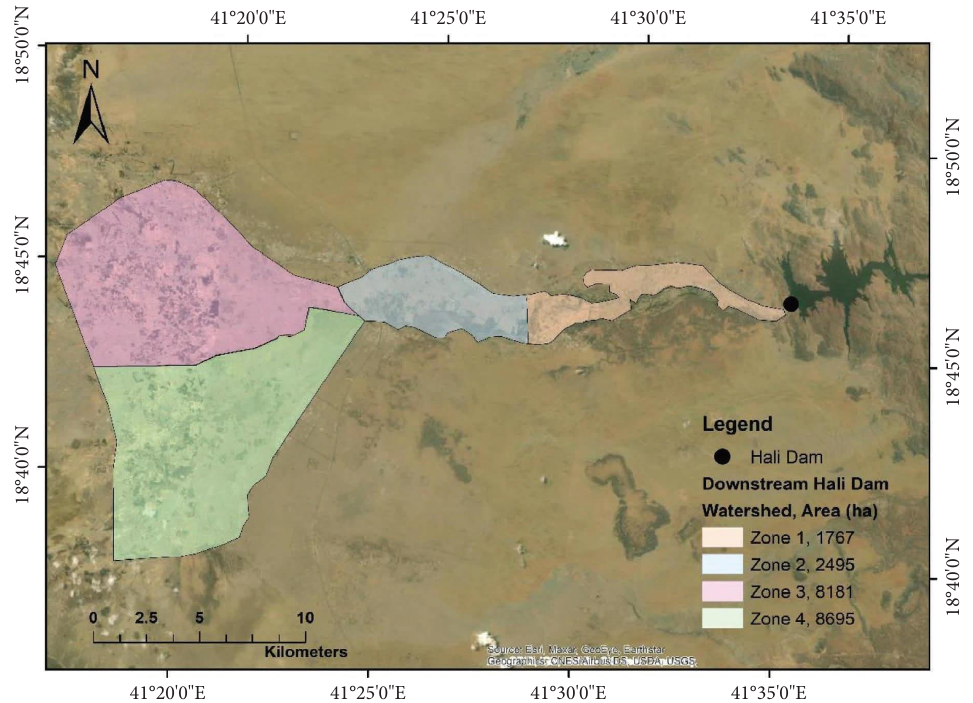
Figure 2: Map showing the reservoir and irrigation